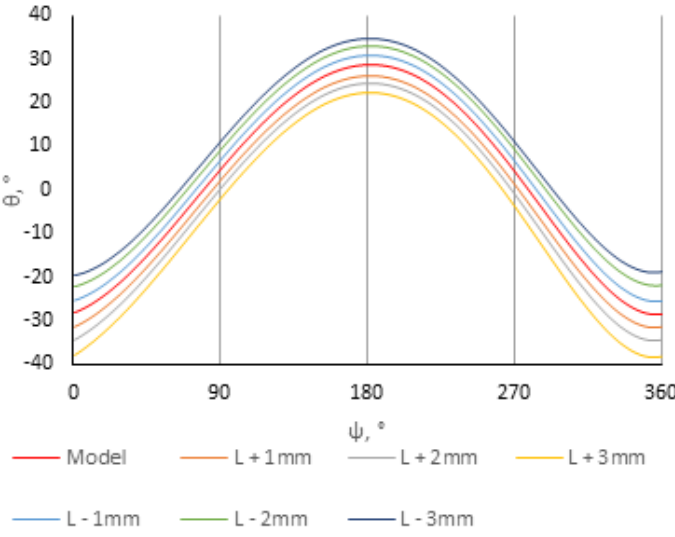
Figure 4. Influence of parameter L on the function curve.